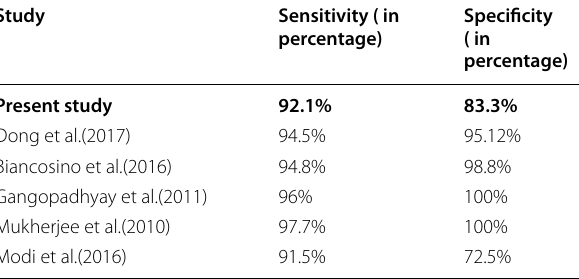
Table 5 Showing sensitivity and specificity of cytology in